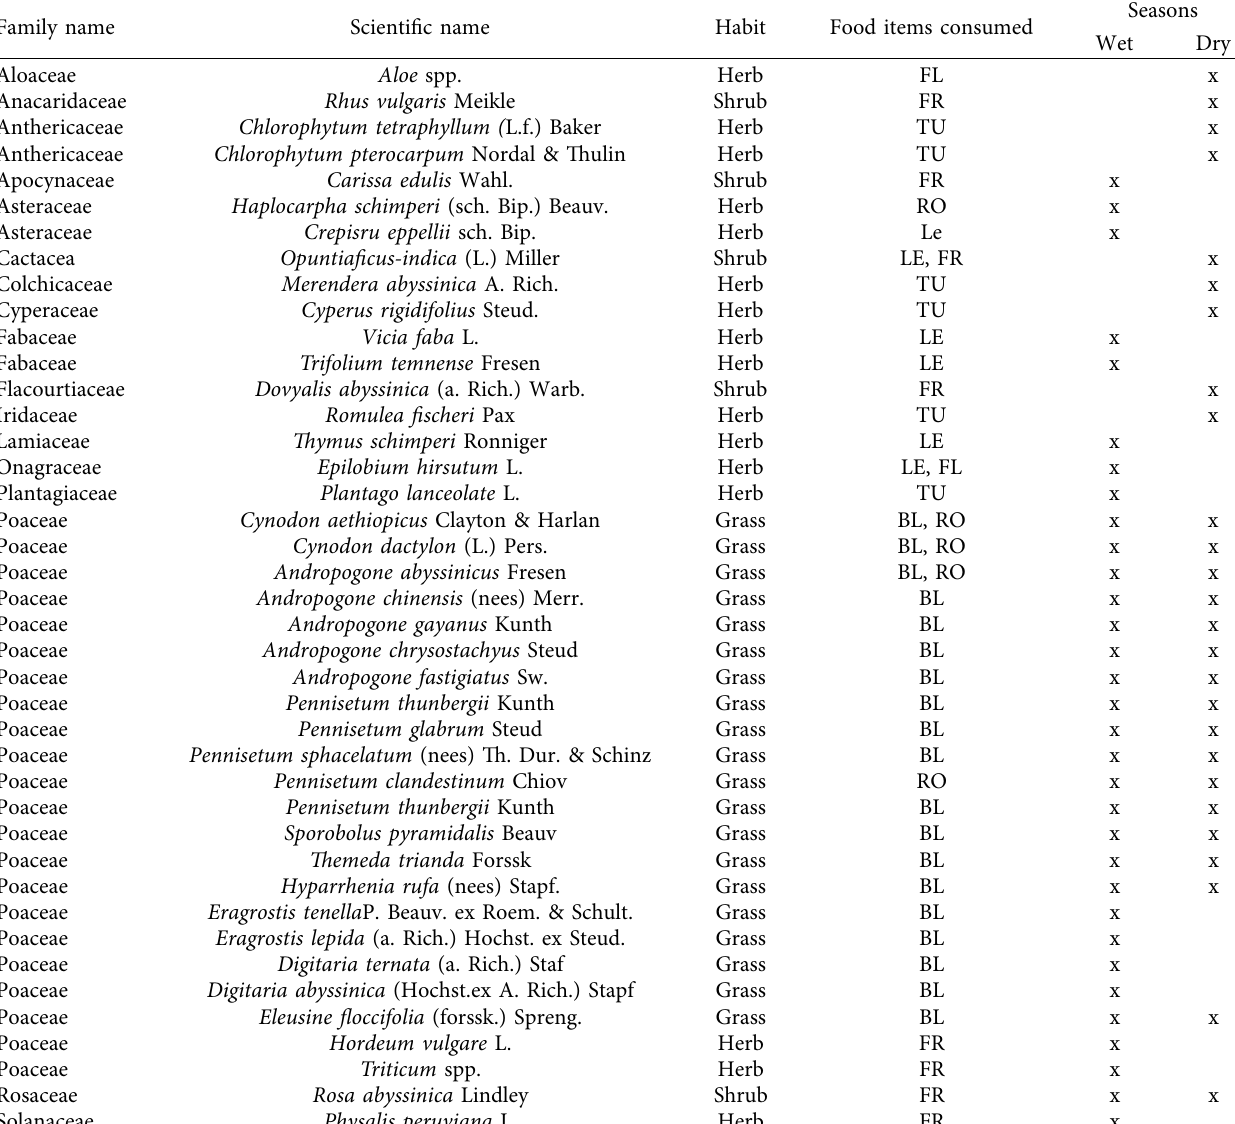
Table 2: List of plant species, parts consumed, and percentage composition of diet consumed by geladas during the study period. Family name